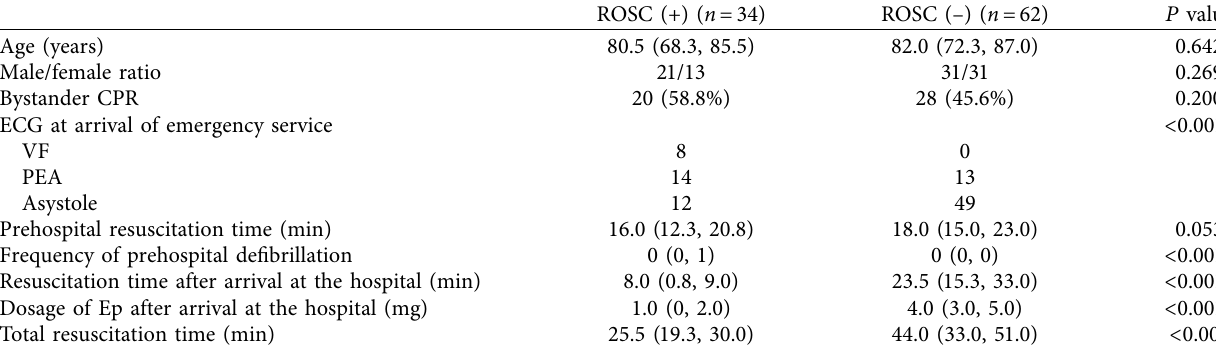
Table 1: Comparisons between the two